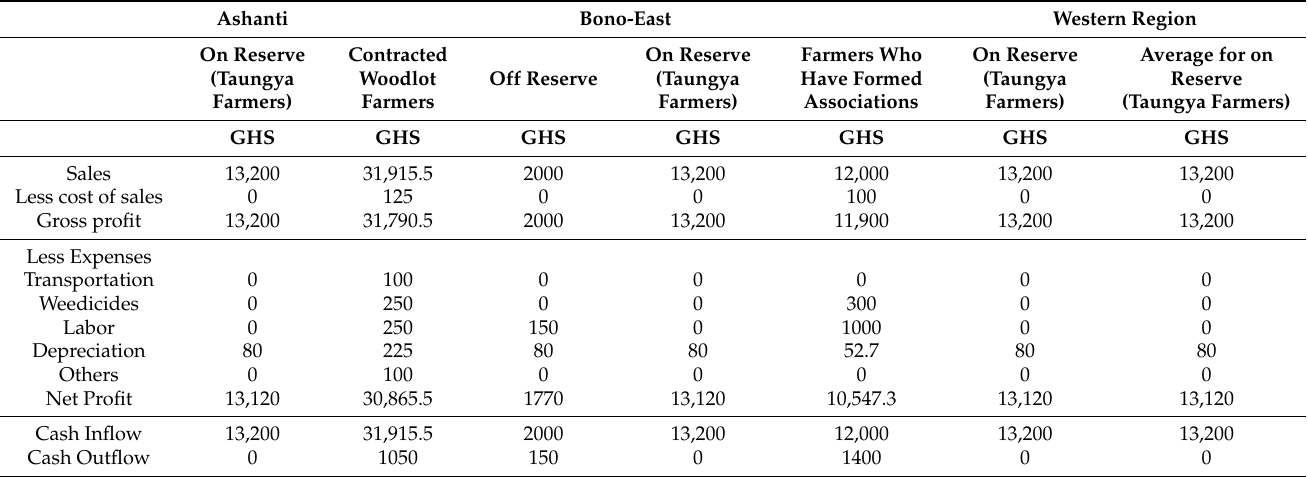
Table 4. Profit and loss statement for woodlot investors in the Ashanti, Bono-East, and Western Regions of Ghana.